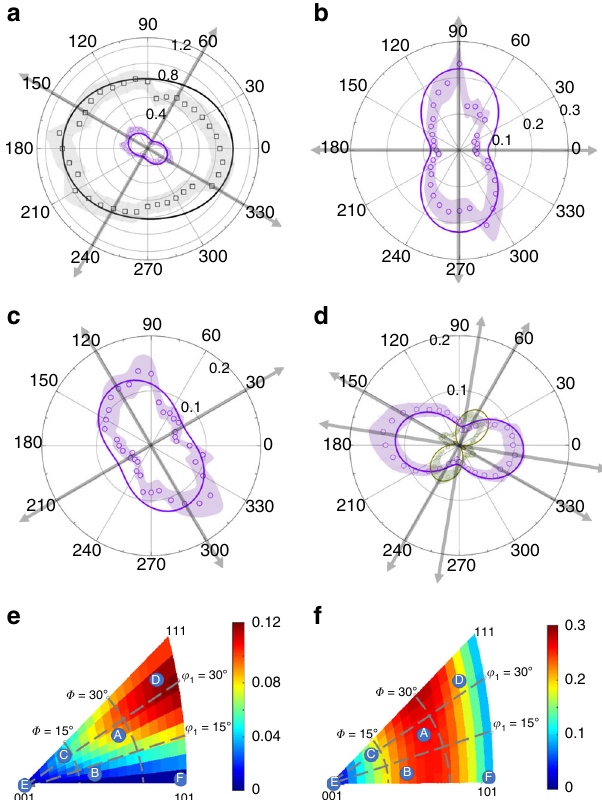
Fig. 3 The shape and orientation of the TA amplitude pro fi le is tied to crystallite orientation. Polar plot of LA (black), normalized FTA (violet), and normalized STA (green) amplitudes for a crystallite A; b crystallite B; c crystallite C; d crystallite D as a function of Ω . The crystallite orientations are summarized in Table 1. Open symbols are experimental results and solid lines are from theory (shading represents measurement error); e displacement ratios STA/LA; and f FTA/LA for different crystallite orientations (represented by a color-coded inverse pole fi